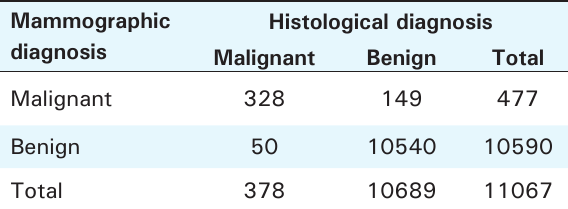
table 2. comparison of mammographic diagnosis